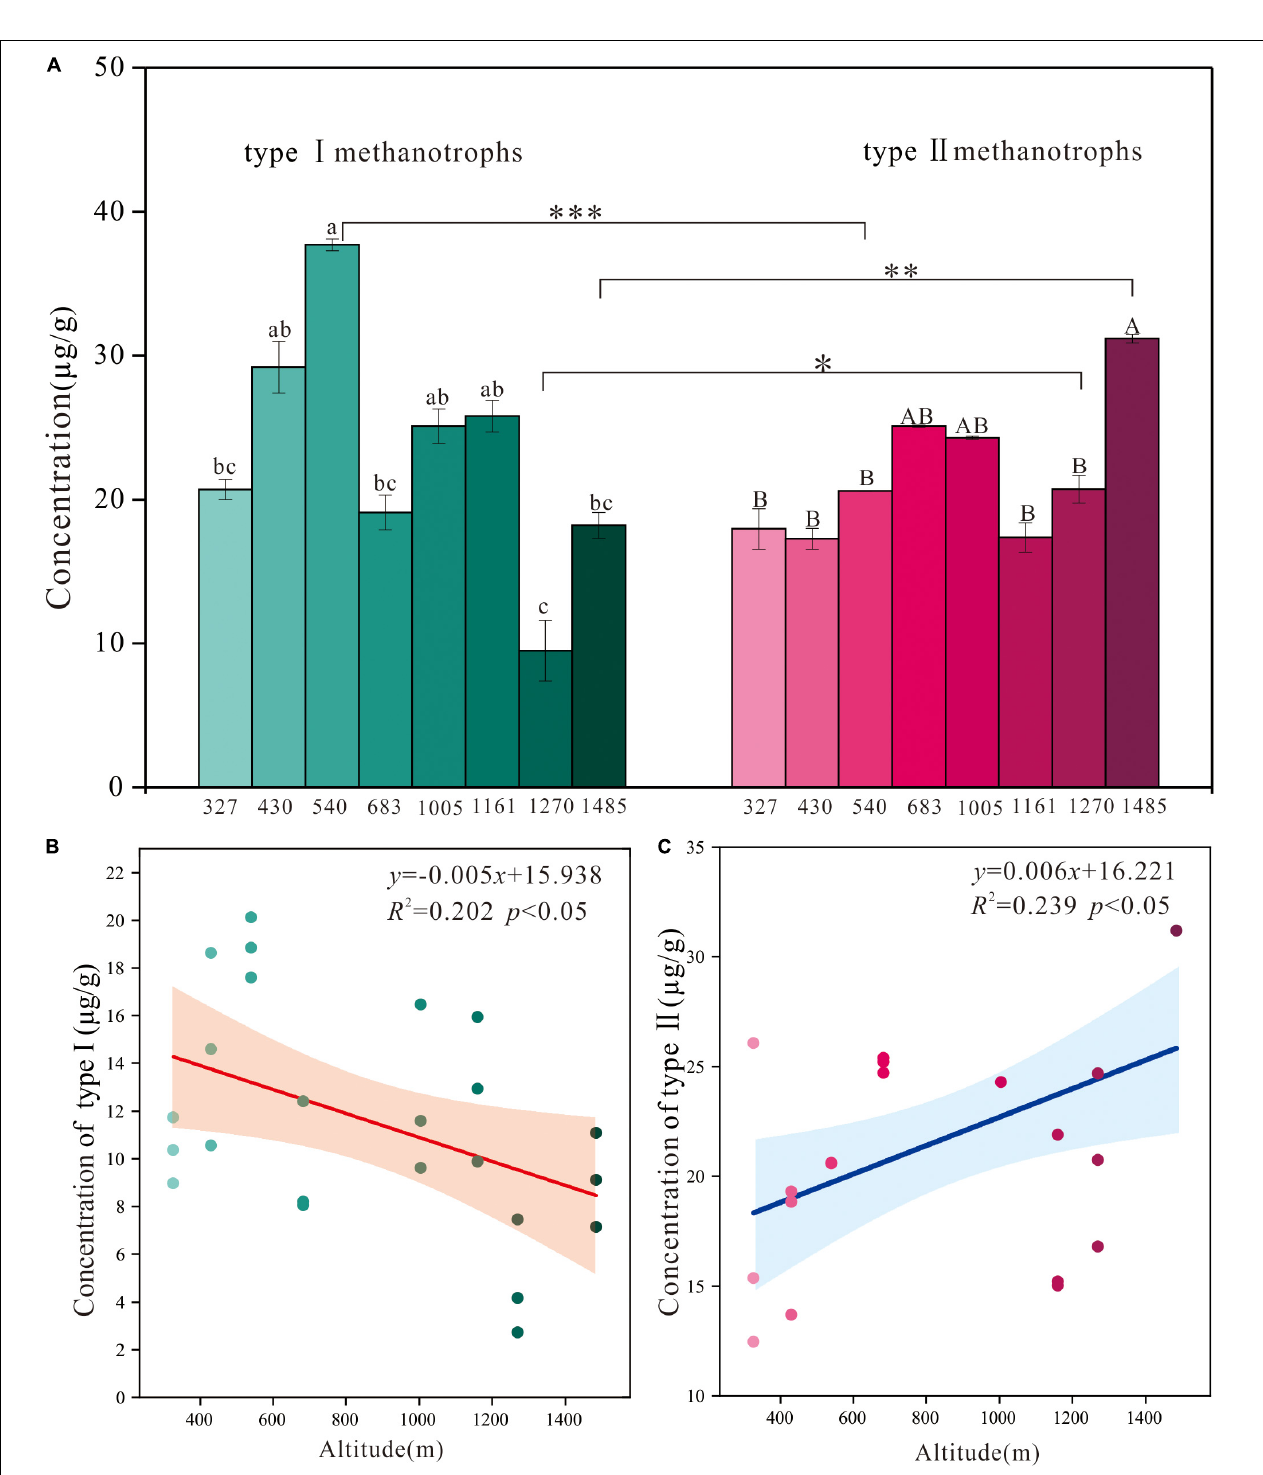
FIGURE 2 | (A) The concentrations of type I and type II methanotroph biomarkers along the altitude gradient on the northern slope of the Changbai Mountain, China. Values were presented as means ± S.E. ( n = 3). Different letters indicate significant differences among study sites based on one-way ANOVA and Tukey’s test ( p < 0.05). The asterisk represents the difference between type I and type II methanotrophs at the same site ( ∗∗∗ p < 0.001, ∗∗ p < 0.01, and ∗ p < 0.05). Regression of the altitude against the concentration of type I (B) and type II (C) methanotroph biomarkers. The R 2 and p values of the regression equation are shown in each panel. Significant relationships are denoted with solid lines, and shadow areas indicate the 95% confidence interval ( CI ) of the fit.